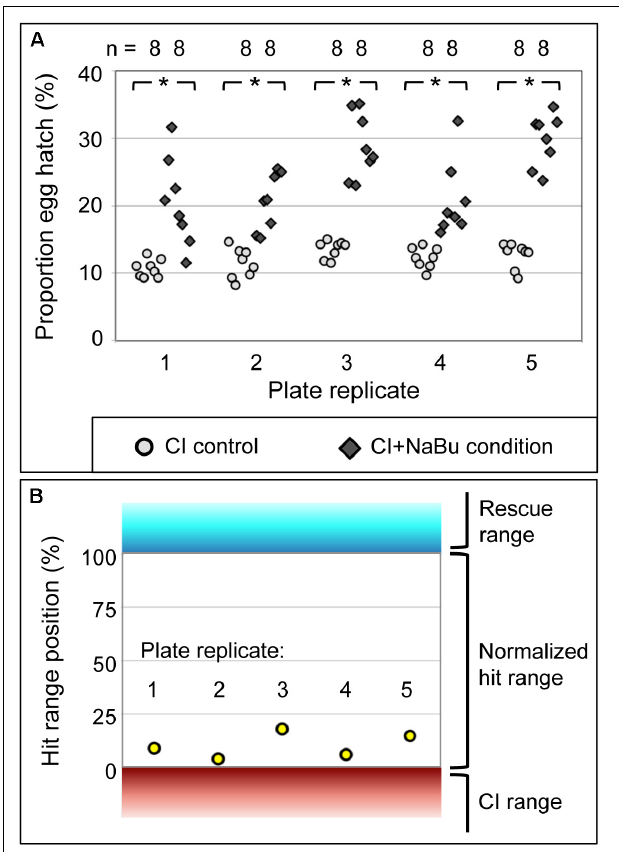
FIGURE 3 | The impact of NaBu treatment on CI egg hatch. (A) Hatch rate data from assay plates using w Ri-infected D. simulans flies. Each symbol represents data from a single well. * p < 0.005. (B) NaBu impact on CI, in terms of conventional Z (cid:48) analysis. Range boundaries of the CI control (red) and Rescue control (cyan) are indicated. The normalized “hit range” between controls is shown in white. Yellow dots: average hatch rate for the CI+NaBu condition per screening plate, normalized to the range between CI and Rescue controls. For further details, see Supplementary Tables S4 , S5 .